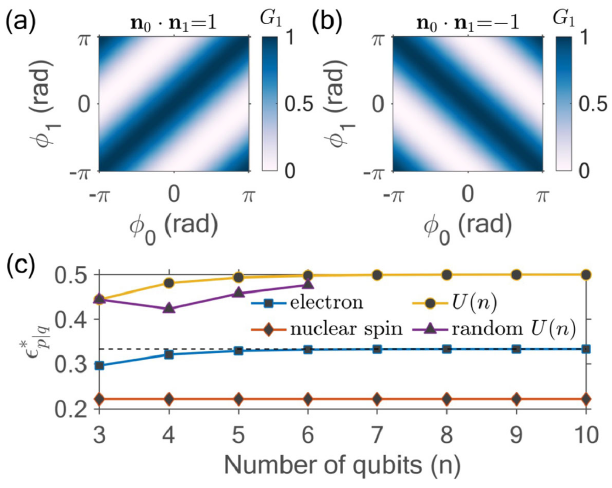
FIG. 4. Function G 1 versus the rotation angles ϕ for the case of j n as a function of the number of qubits for the case when the electron (blue line) or a single nuclear spin (red line) is partitioned from the rest of the system. The yellow line is the theoretical maximum bound for a perfect U ð n Þ entangler, while the purple line is the numerical bound we find for randomly generated U ð n Þ , obtained by retaining the maximal value over 100 random unitaries for n ¼ 4 , 5 and five random unitaries for n ¼ 6 . For n ¼ 3 , we construct a U ð n Þ from an absolutely maximally entangling (AME) state. Such U ð n Þ saturates the bound, if the AME ð 2 n; d Þ state exists (in this case, d ¼ 2